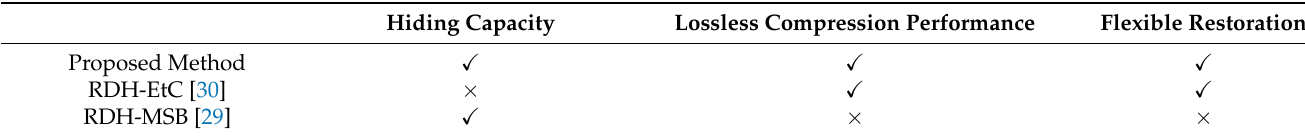
Table 1. Feature comparison of the proposed method with related work.